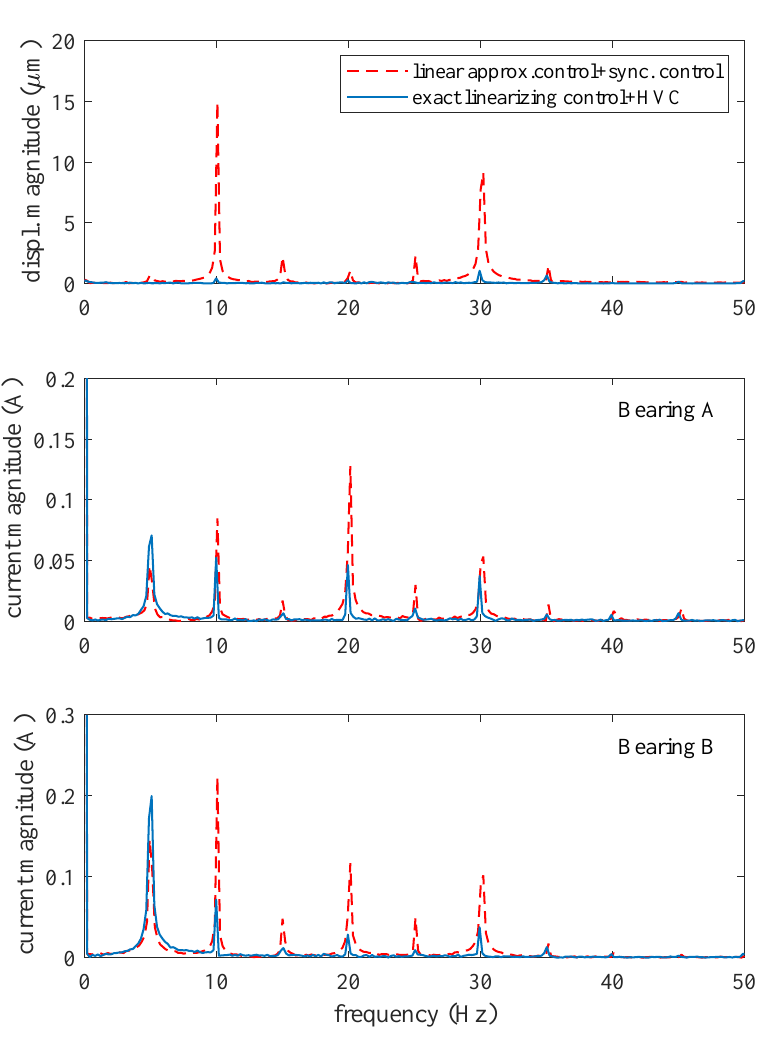
Figure 15. Fourier transforms of displacement and current signals at rotational speed of 31.2 rad/s (5 Hz). Data is shown for x -axis components from each case in Figure